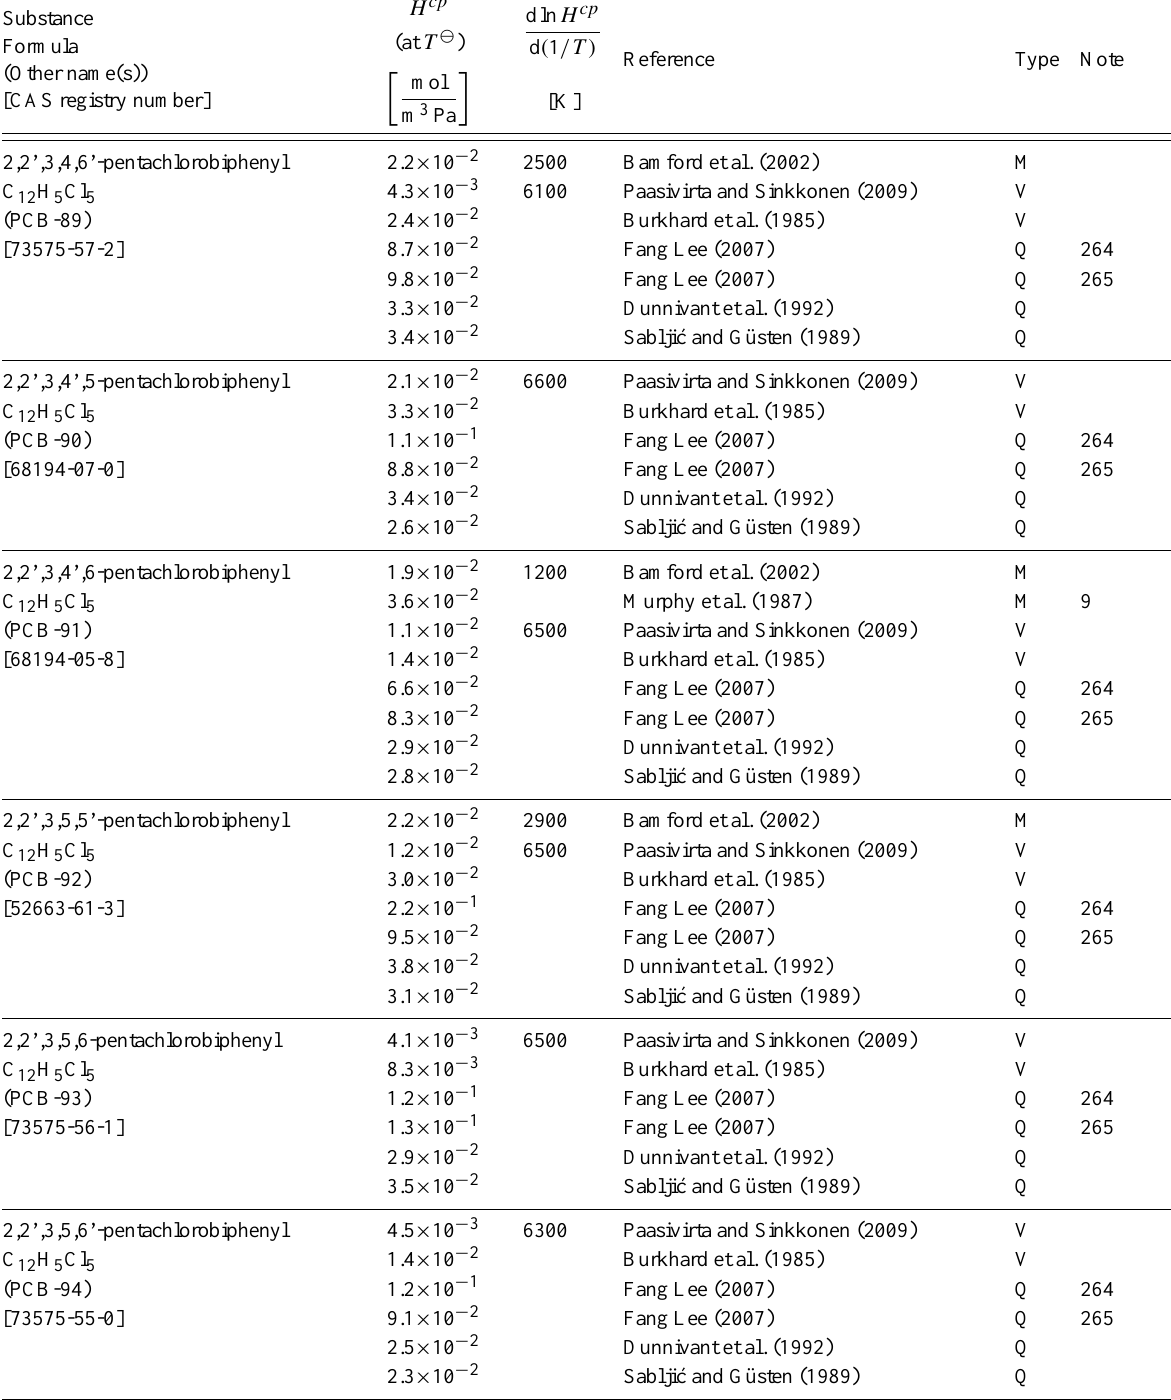
Table 6: Henry’s law constants for water as solvent